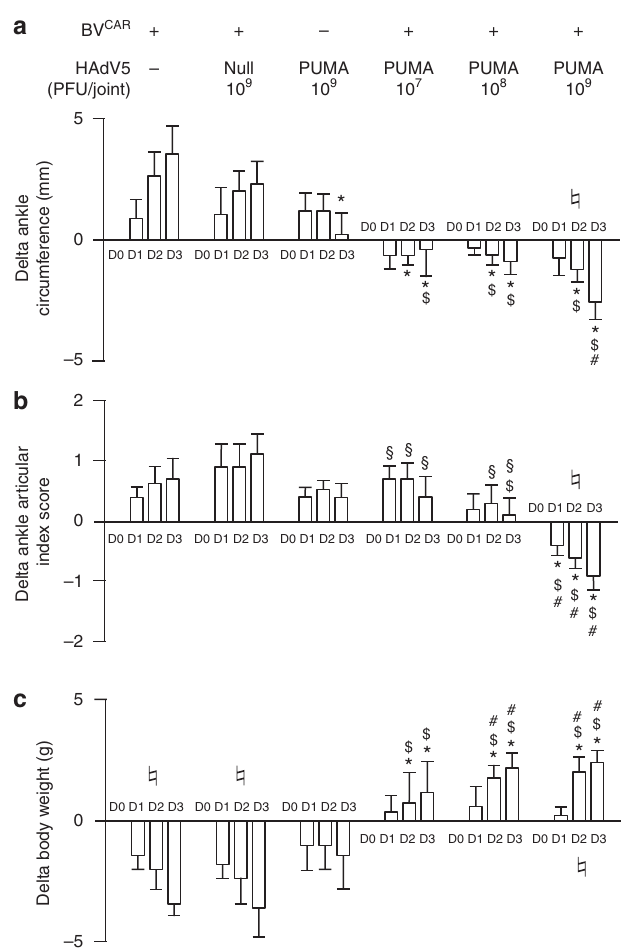
Fig. 4 BV CAR HAdV5-PUMA-mediated reduction of joint in fl ammation. Rats develop arthritis 8 – 10 days after adjuvant injection. After the onset of arthritis, at day 14 post injection, vectors (10 μ l) were delivered intra- articularly in each ankle. Thirty rats were enrolled and divided into six groups ( fi ve rats per group). Three control groups consisted of BV CAR alone (10 5 PFU per joint), BV CAR (10 5 PFU per joint) complexed with an empty adenoviral vector (HAdV5-null; 10 9 PFU per joint), and HAdV5-PUMA alone (10 9 PFU per joint). The three therapeutic groups consisted of BV CAR (10 5 PFU per joint) complexed with HAdV5-PUMA at increasing concentrations (10 7 , 10 8 and 10 9 PFU per joint). Values represented in the bar graphs are the means ± s.e.m. Differences (Delta) in the biological parameters are de fi ned by the values obtained on the day of follow-up minus the values obtained on the day of intra-articular injection. a Differences in ankle circumferences. Values of ankle circumferences were obtained from perpendicular caliper measurements of ankle diameter, using a geometric formula. b Differences in ankle articular index scores. c Differences in rat body weights. D day after intraarticular injection of vector; * P < 0.05 vs BV CAR alone; $ P < 0.05 vs BV CAR HAdV5-null; # P < 0.05 vs HAdV5-PUMA alone; § P < 0.05 vs BV CAR HAdV5-PUMA (10 9 PFU per joint); ♮ P < 0.05